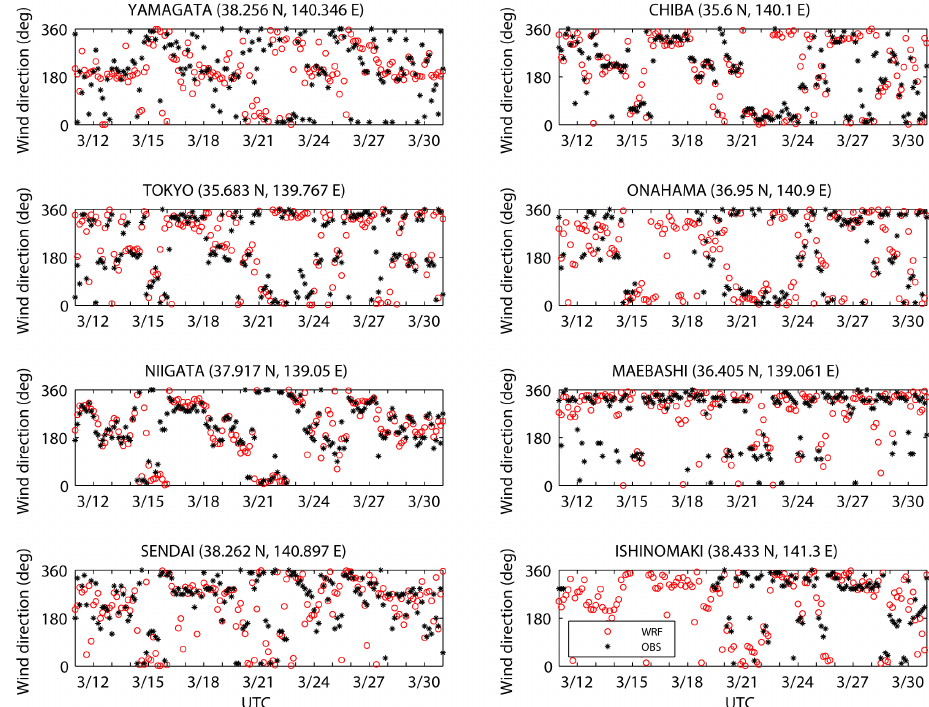
Figure 4. Simulated and observed surface wind directions at eight stations over Japan during the period from 00:00UTC, 11 March to 00:00UTC, 31 March 2011 (case REF). Output from the simulation is collected every 1 hour, but we only display on the figure data with 3h resolution for clarity. Red circles represent the simulated data from WRF and the black asterisks represent the observed